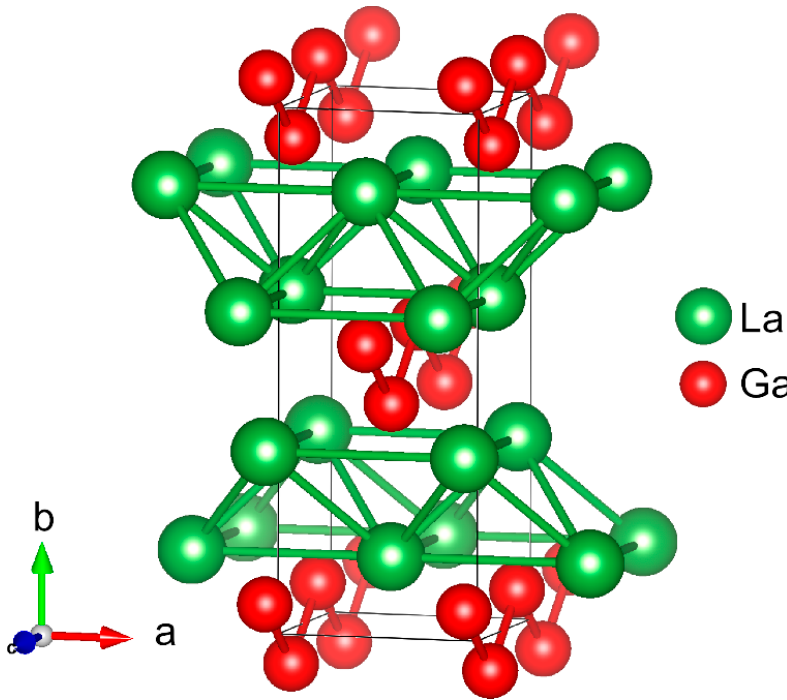
Figure 1. Crystal structure of LaGa; Ga zig-zag chains and tetrahedral voids are highlighted.